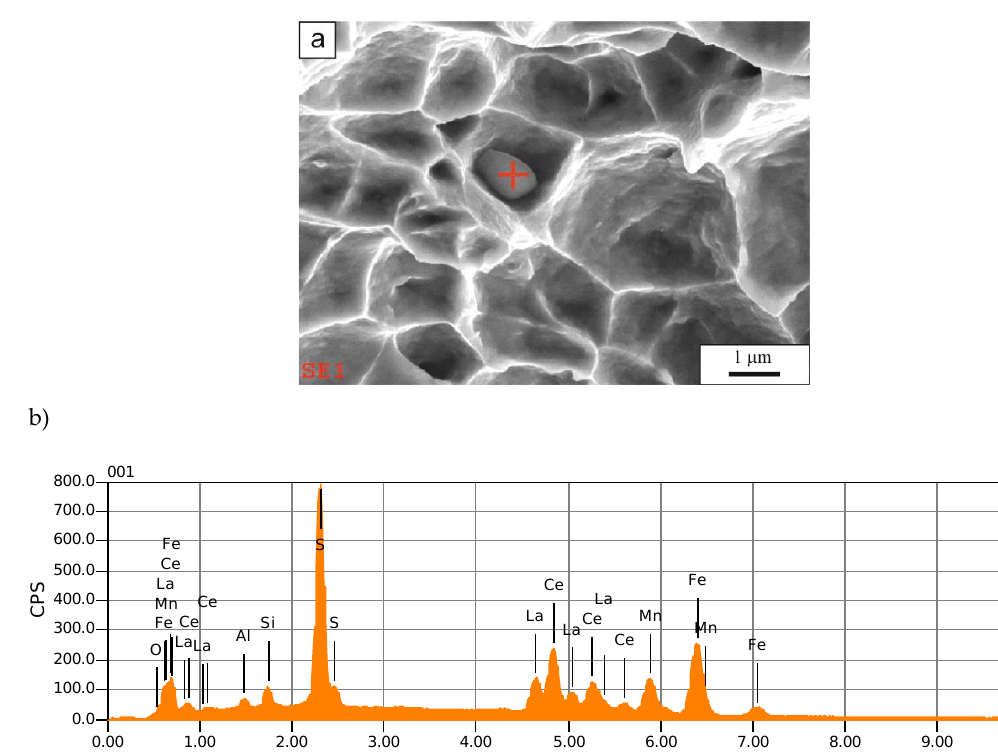
Figure 6. Manganese sulphide partially modified with rare earth elements: ( a ) the inclusion view, ( b ) the EDS spectrum of the inclusion; solution annealing temperature of 1100 °C.